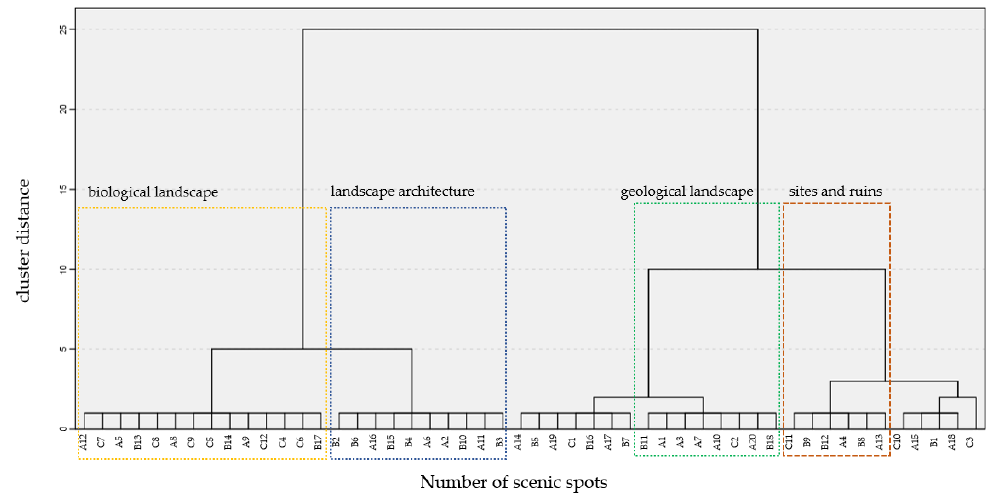
Figure 5. Hierarchical clustering dendrogram of the three measurements.